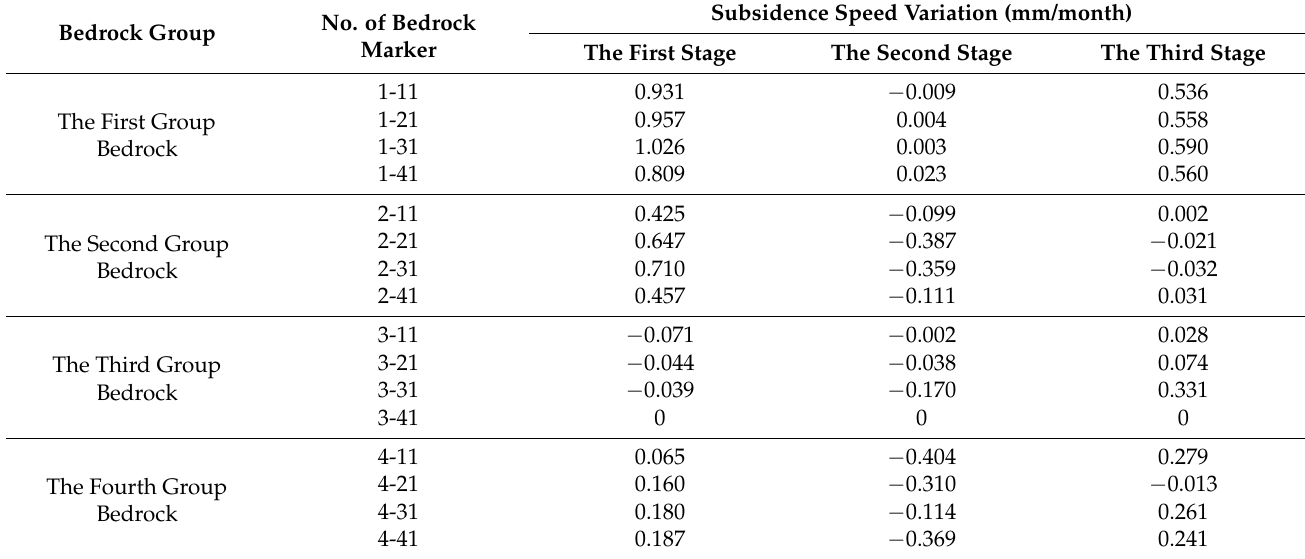
Table 2. Subsidence speed variation for bedrock markers in the